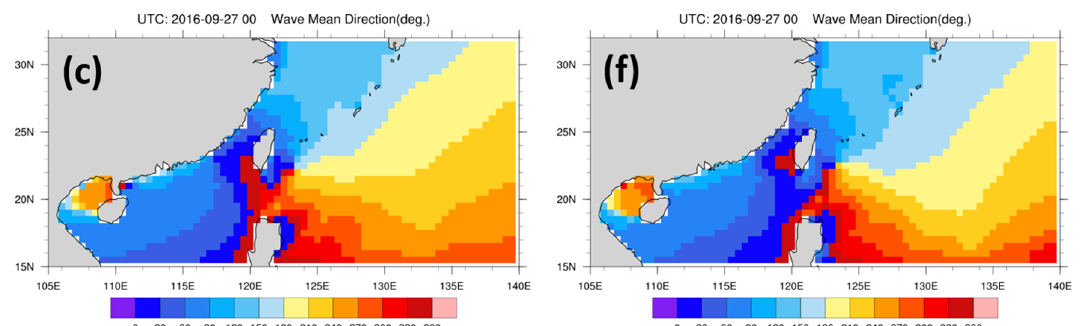
Figure 6. Spatial distribution of wave direction driven by the CFSv2 ( a – c ) and the ERA5 ( d – f ) winds; a WW3 model with a 0.50 deg grid resolution was used for Typhoons Meranti ( a , d ), Malakas ( b , e ), and Megi ( c , f ).